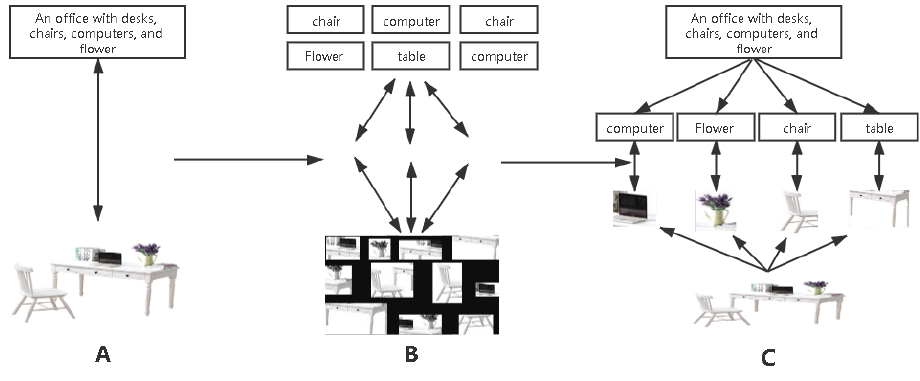
Figure 1. Correspondence between image and text. ( A ) One to one; ( B ) One to many; ( C ) Many to